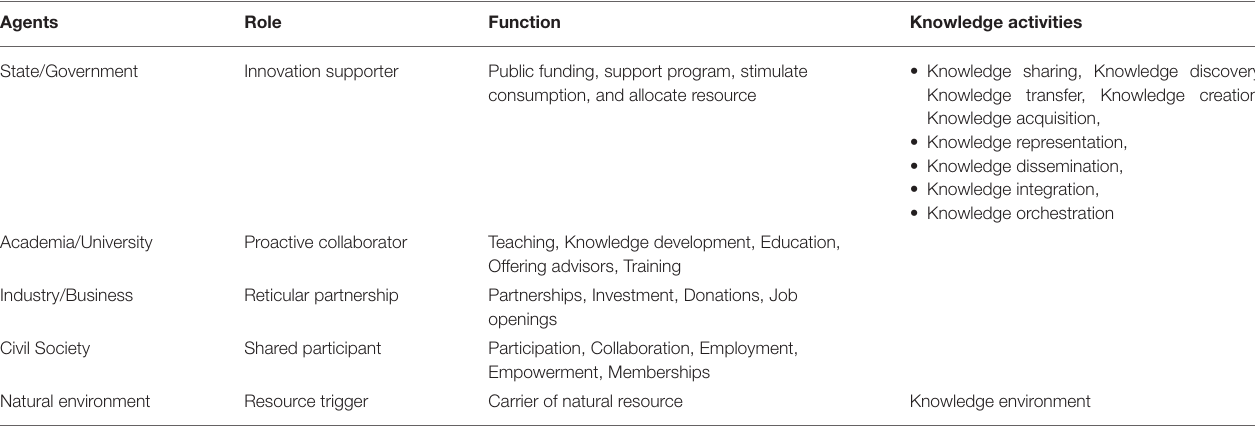
TABLE 6 | The roles and functions of five agents in the helical